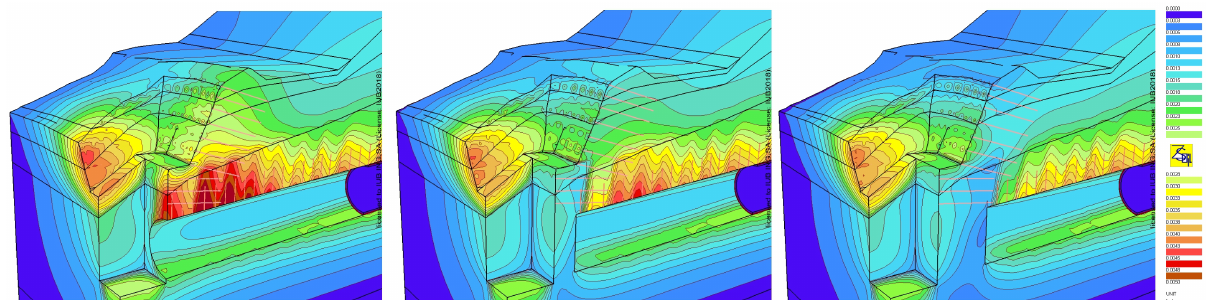
Figure 7. Increase of SLS displacements during boring of the gallery (from right to left); max. displacement (brown colour) is 5 mm with contours 0.2 mm